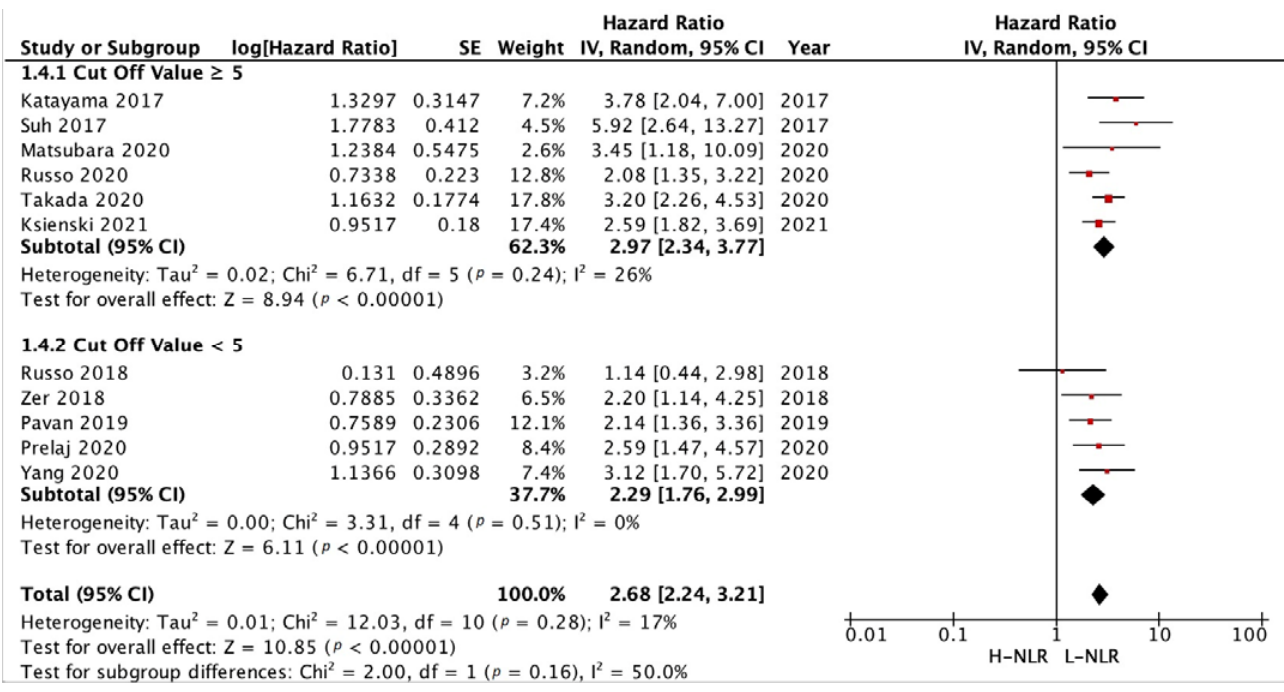
Figure 9. Forest plot cut-off value subgroup analysis of H-NLR versus L-NLR to OS in patients treated with immunotherapy. Red dots represent study weights; the bivalve represent the overall effect.